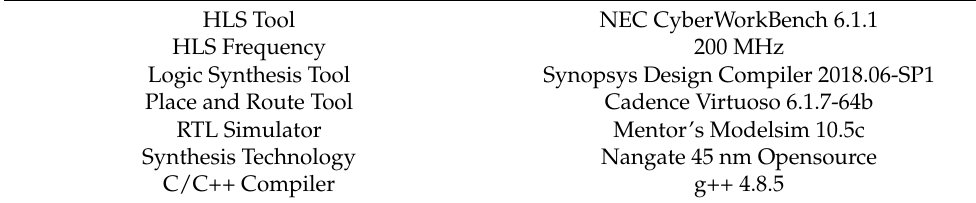
Table 6. Experimental setup.